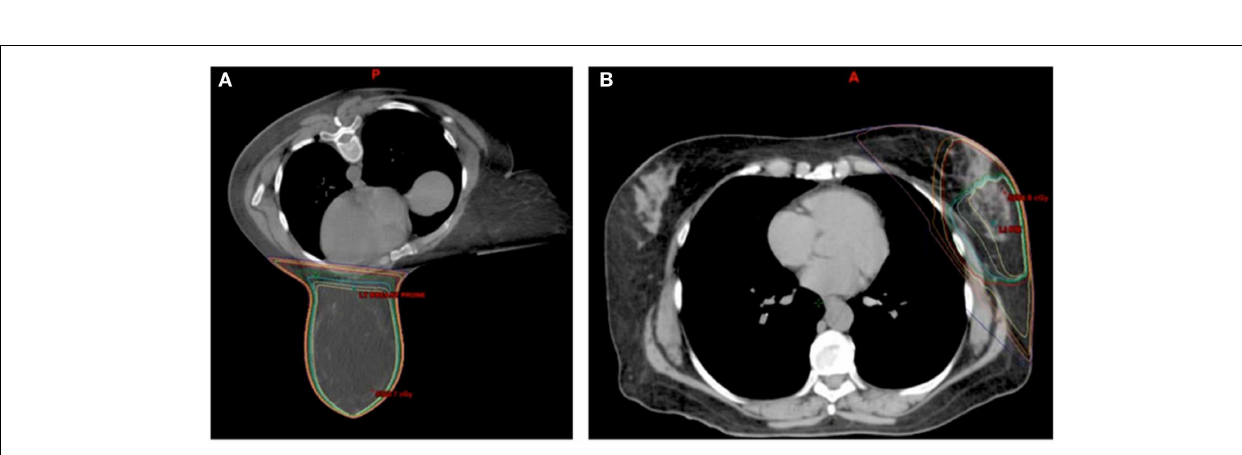
FIGURE 2 | Examples of (A) prone breast and (B) external beamAPBI plans